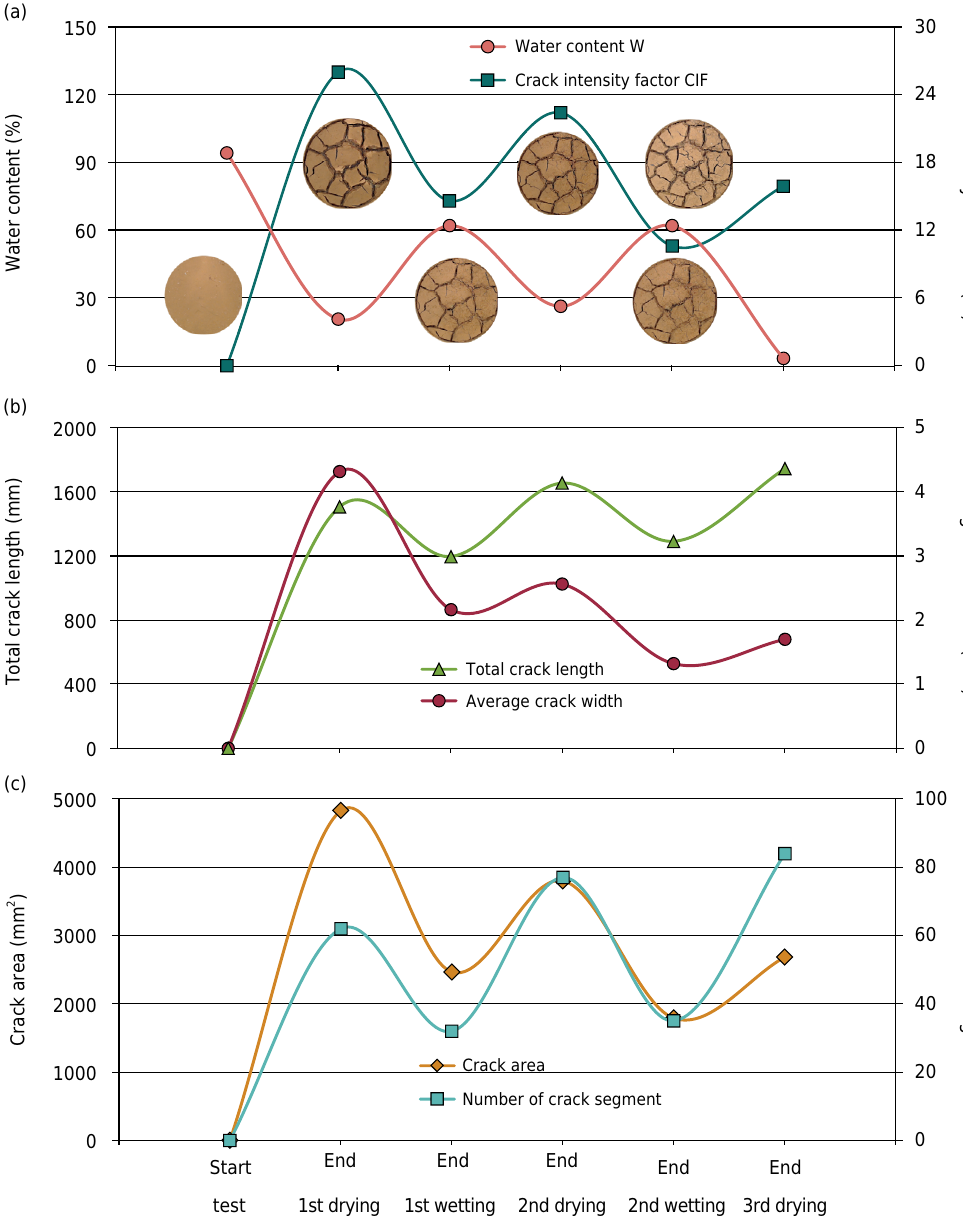
Figure 9. Variation of geometric crack indexes with drying and wetting